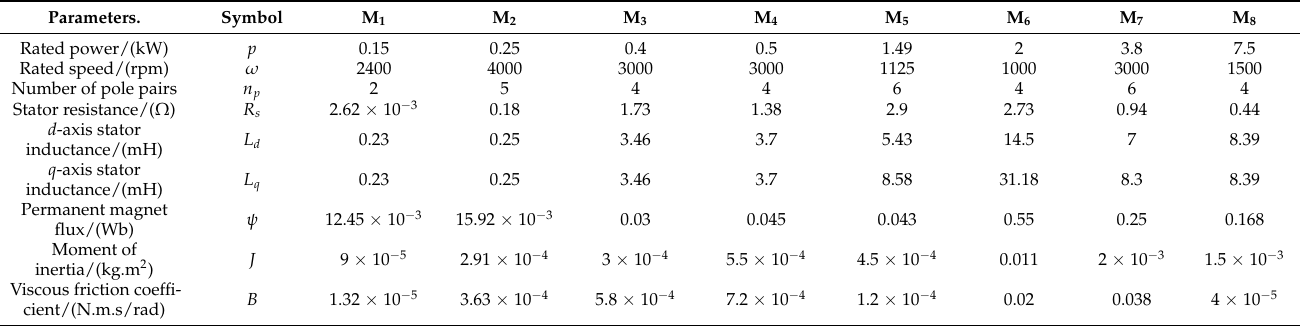
Table 1. Parameters of all permanent magnet synchronous motors